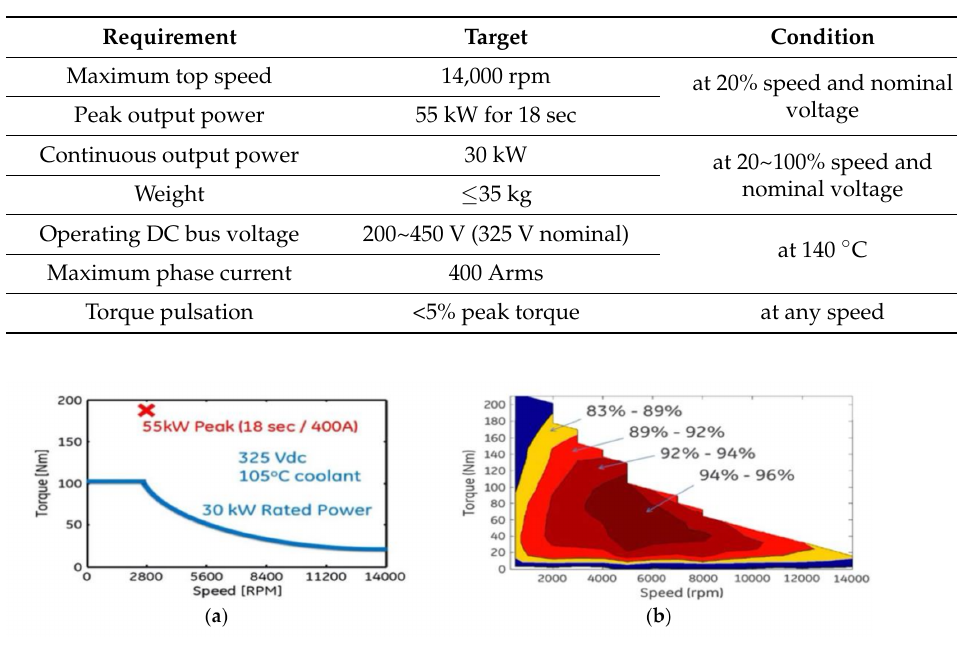
Figure 11. FreedomCar 2020 ( a ) design requirements, and ( b ) efficiency